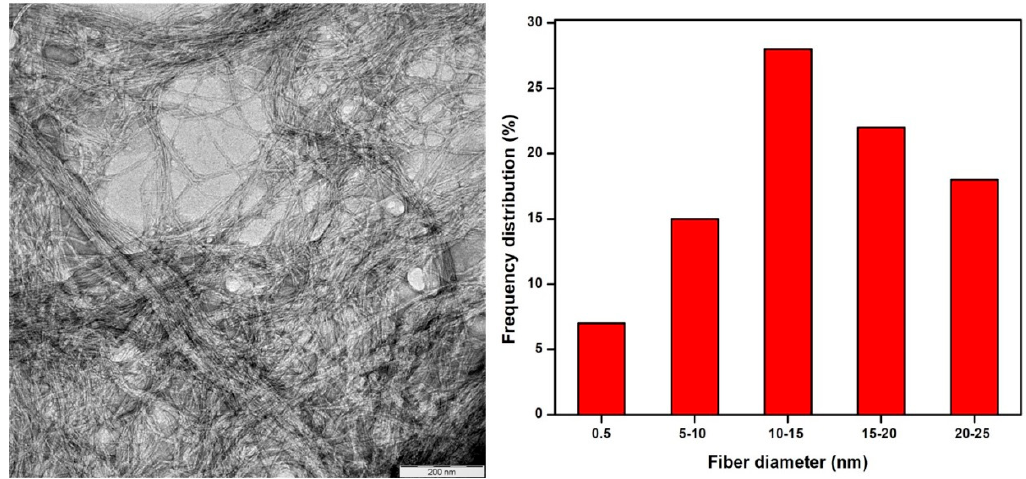
Figure 1. TEM image and diameter frequency distributions of supercritical carbon dioxide (SC-CO 2) cellulose nanofibers (CNFs) from kenaf fibers (inset scale is 200 nm).